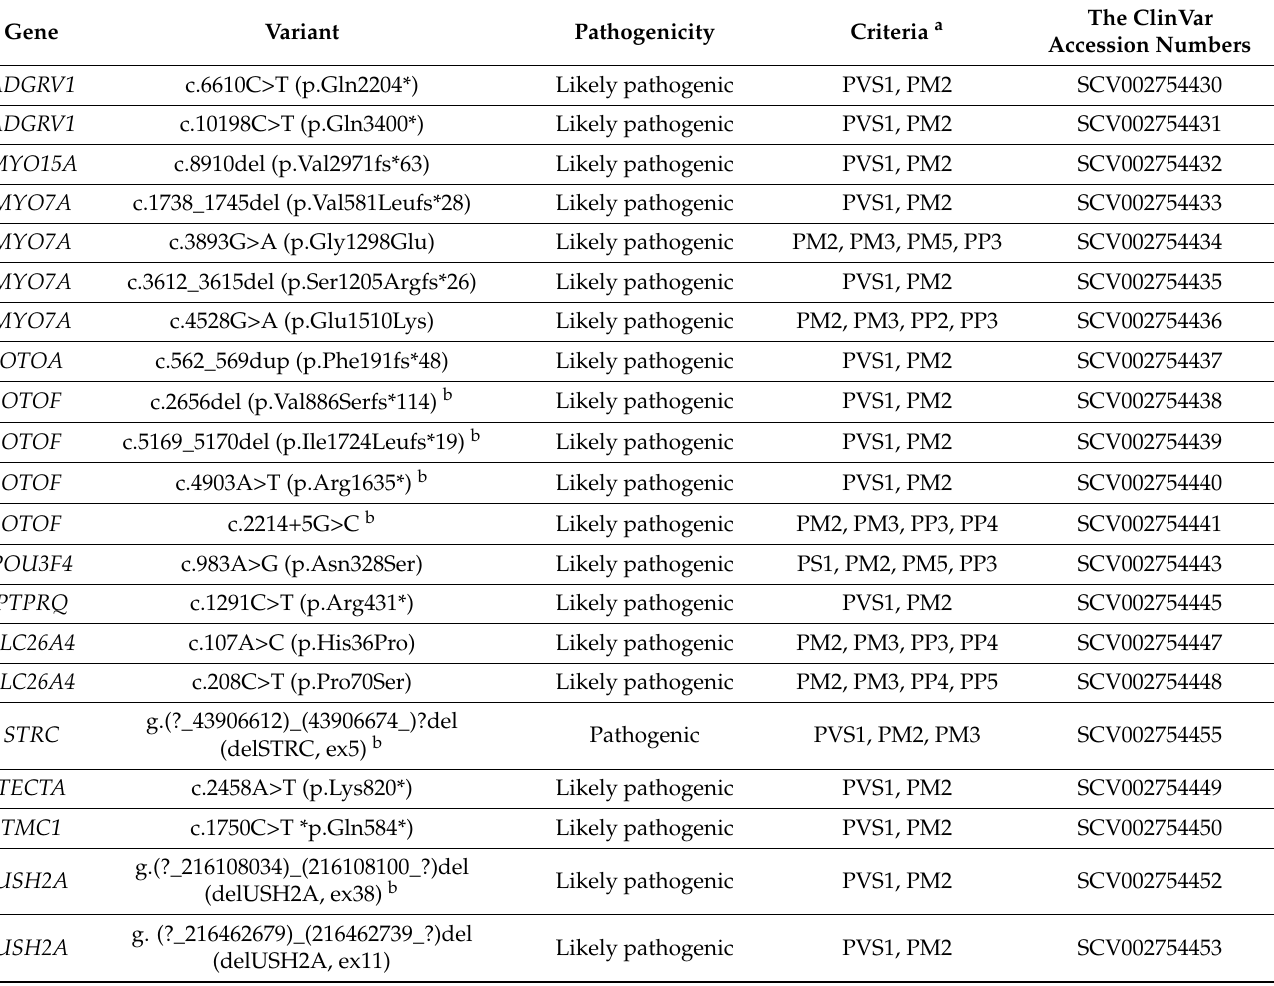
Table 1. Pathogenicity of the novel variants: a—designations are given in accordance with the ACMG recommendations for the interpretation and classification of nucleotide sequence variants [17,18]. b—variants identified in the same patients are presented in the articles by Markova et al. and Lalayants et al.